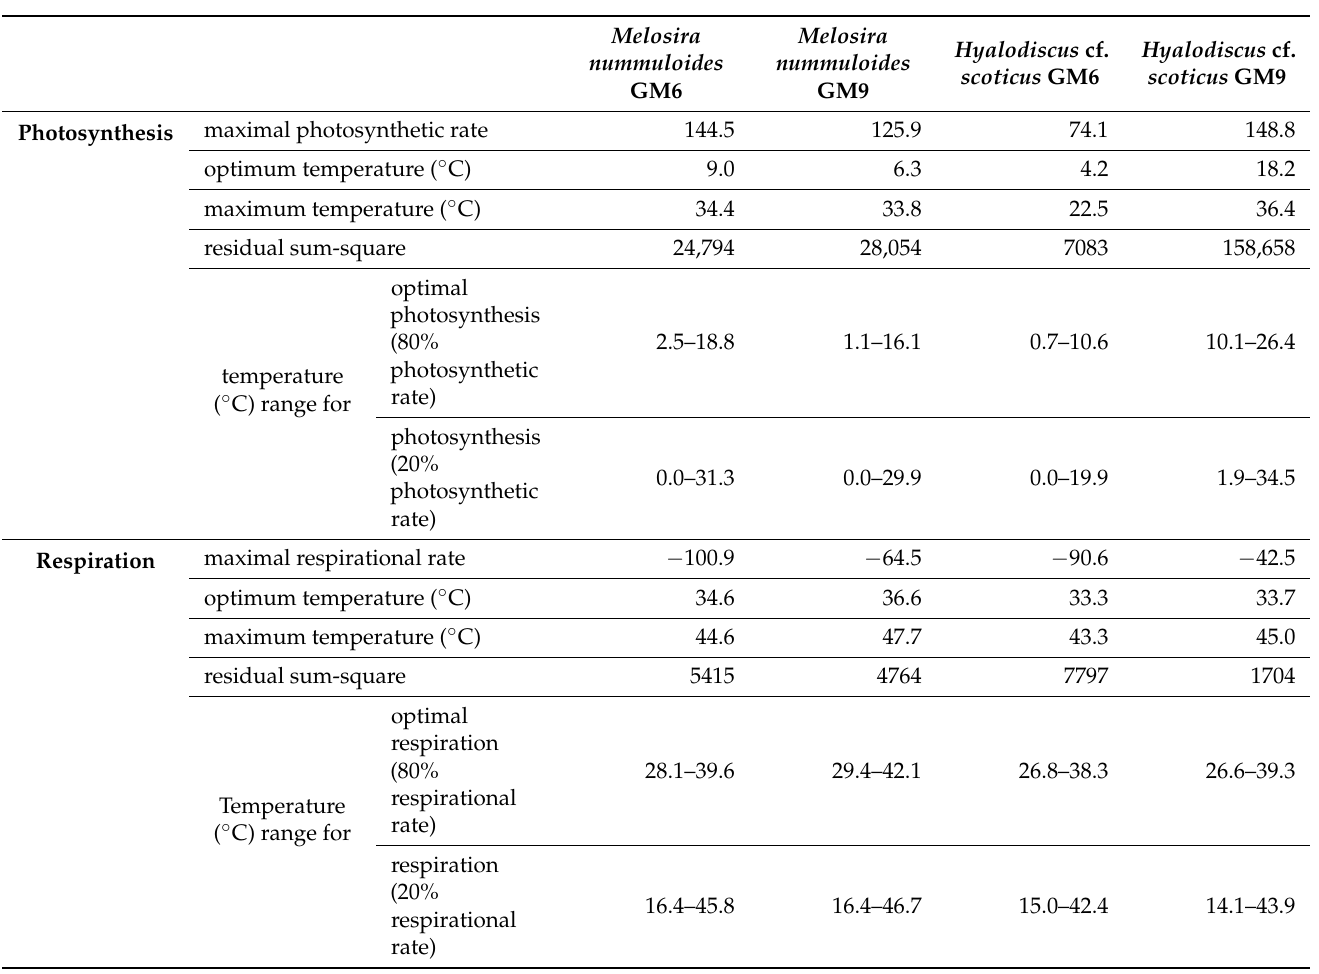
Table 3. Results of model calculation for temperature-dependent photosynthetic and respirational